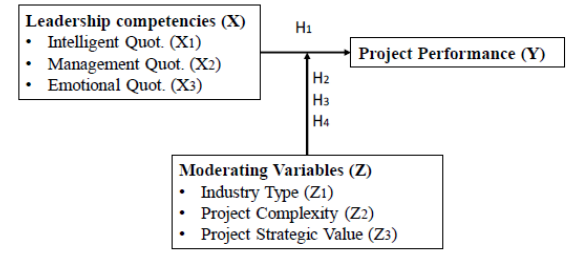
Figure 1. The Theoretical